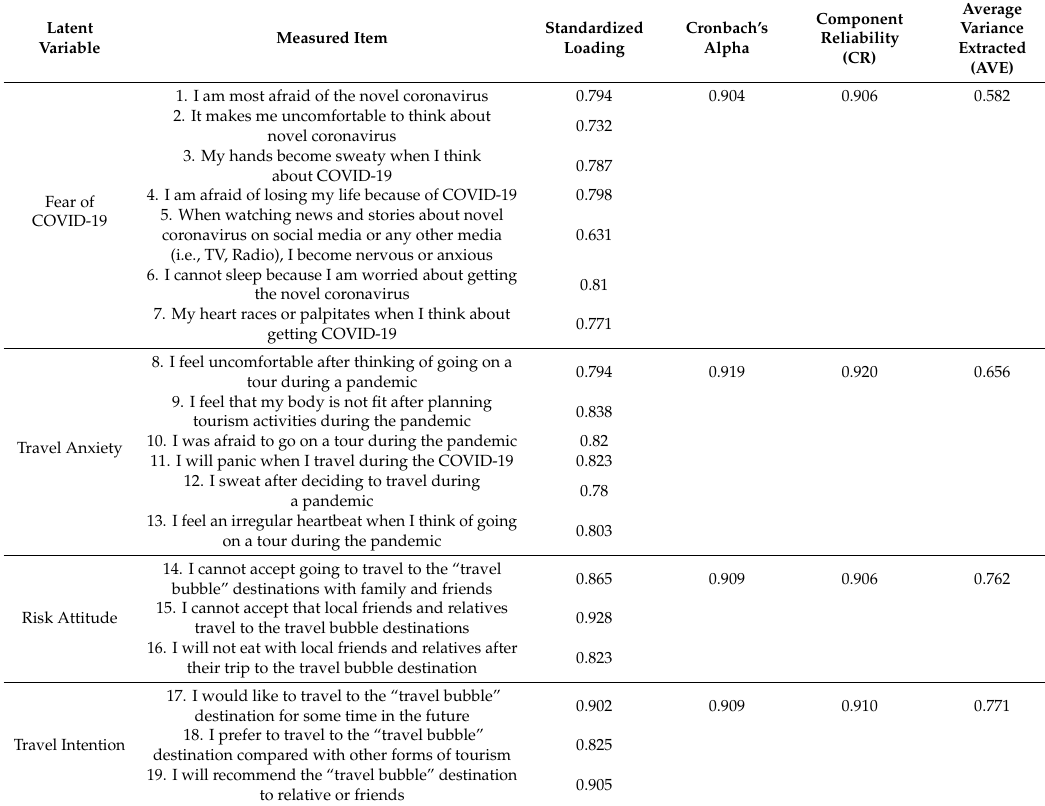
Table 2. Results of Confirmatory Factor